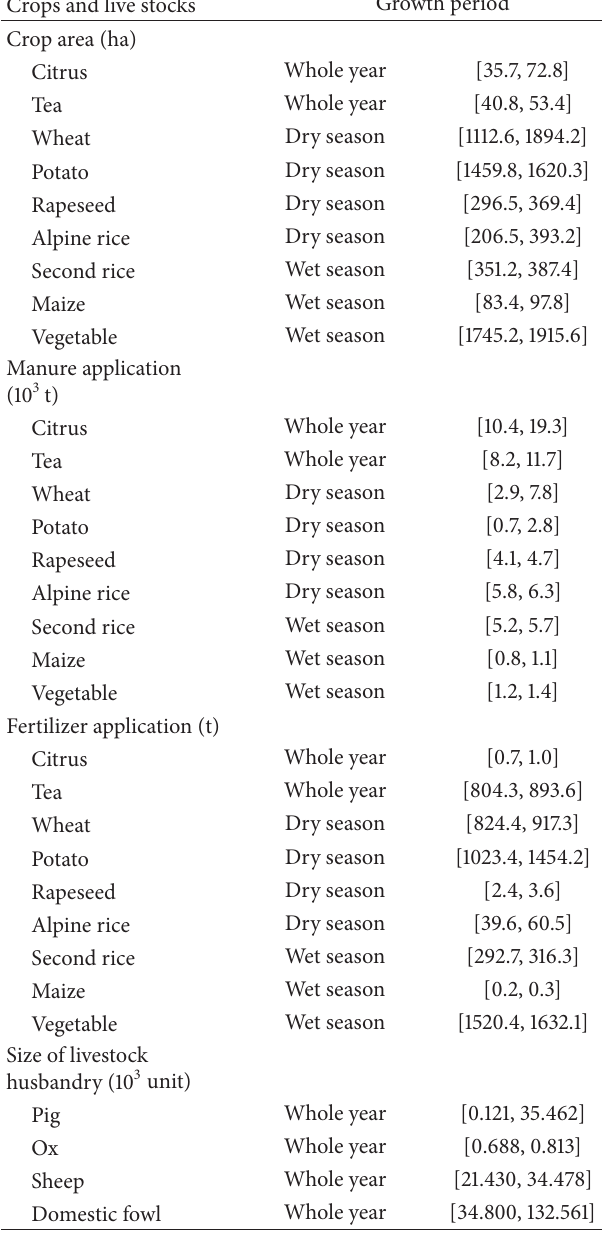
Table 5: Solutions for agricultural production. Crops and live